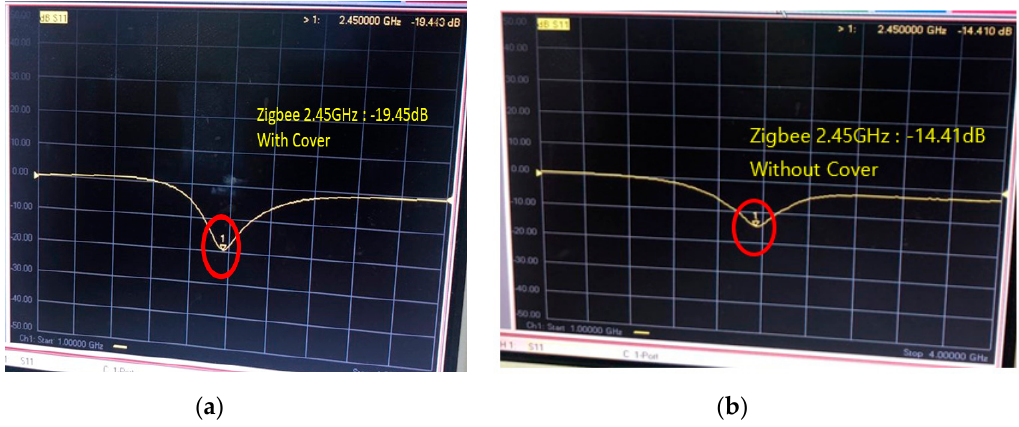
Figure 8. Measured return loss of the fabricated IFA antenna of the sensor module ( a ) with the cover of the module and ( b ) without the cover of the module.